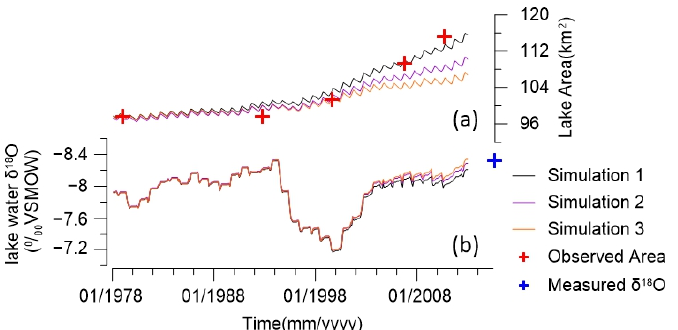
Figure 3. Calibration results of Linggo Co. ( a ) Lake hydrologic simulation results; ( b ) lake water isotopic simulation results. The parameters of each test are listed in Table 1.